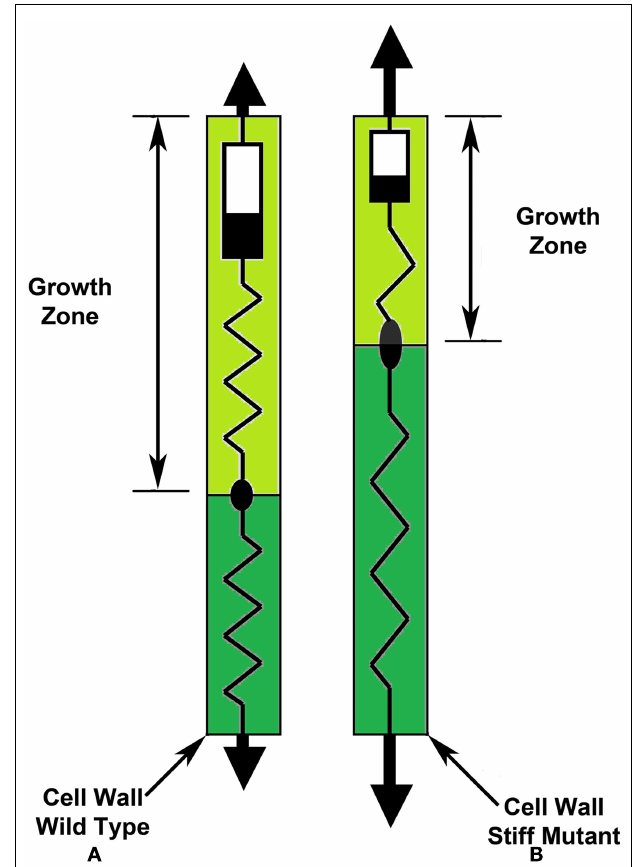
FIGURE 8 | Schematic illustrations of the wall mechanical properties exhibiting tip growth for wild type (A) and stiff mutant sporangiophores (B). Both the growth zone length and the irreversible extensibility (Bingham dashpot) are larger for wall from wild type sporangiophores (A) compared to walls from stiff mutant sporangiophores (B) . Also, the cell walls of the stiff mutant sporangiophores (B) are